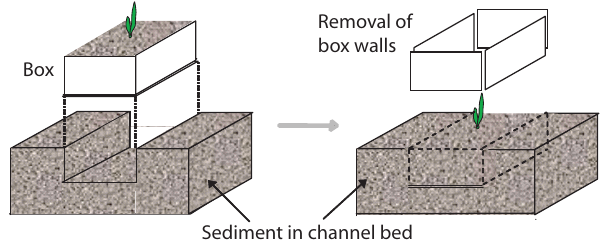
Fig. 5. Box system to insert germinated seedlings into the flume bed.